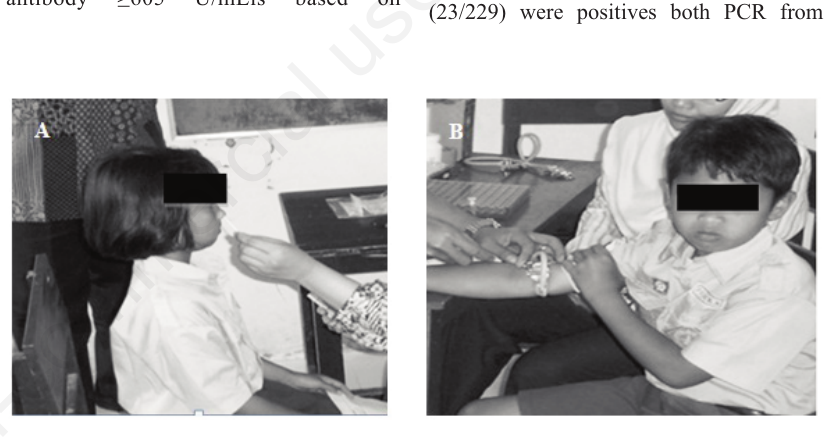
Figure 1. Field survey in the context of taking nasal swab (A) and blood (B) specimens in school children in endemic leprosy area in north coast (Lamongan District) and non- endemic leprosy area in south coast (Pacitan District).